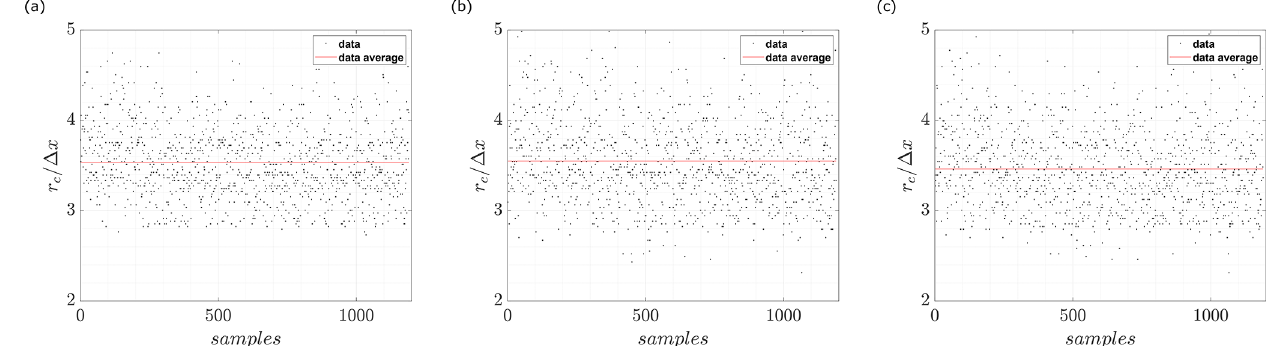
Figure 18. Normalized core radius. (a) Graftieaux. (b) Vorticity magnitude with CD scheme. (c) Vorticity magnitude with LS scheme. Table 4. Convection velocity magnitudes from the average velocity field and the statistics after instantaneous velocity field analyses. VIM Scheme From average velocity From instantaneous field analysis velocity field analyses u c /u ∞ v c /u ∞ u c /u ∞ v c /u ∞ SD Graftieaux 8 points 0.88 − 0.05 0.92 − 0.02 0.10–0.13 24 points